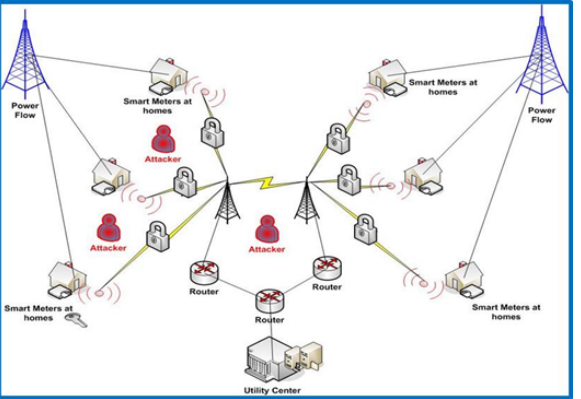
Figure 5. Implementing and applying a man-in-the-middle (MITM) attack and network intrusion detection system (NIDS) in our topology.